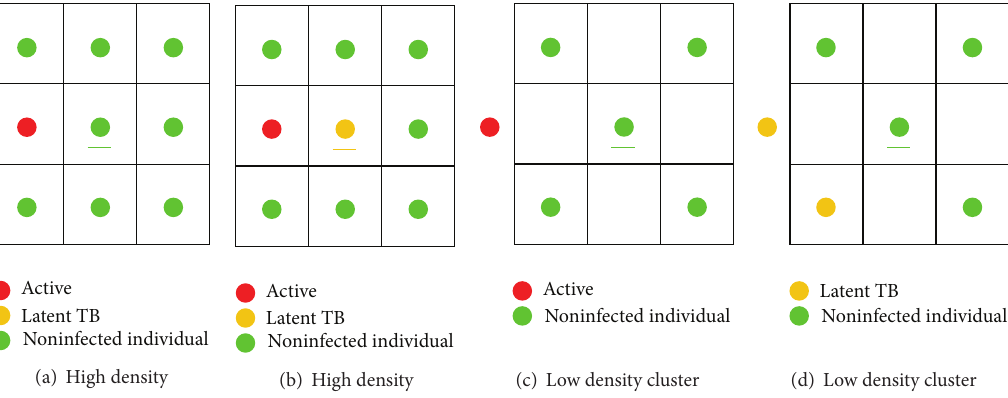
Figure 2: Example of high density (a, b) and low density (c, d) local spatial population matrixes at time 0 (a, c) and time 𝑡 (b, d) and effect on a particular individual (underlined dot).